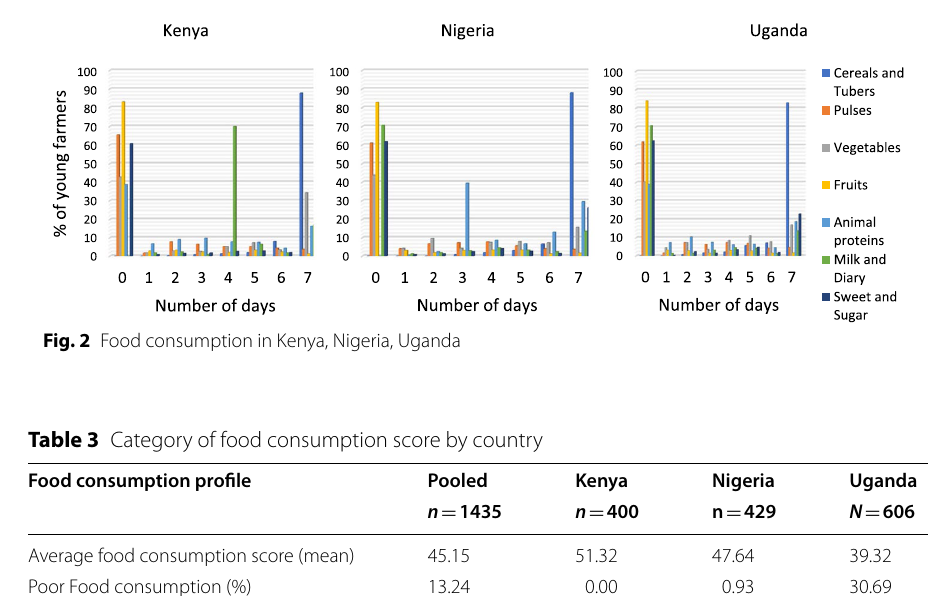
Source Survey data